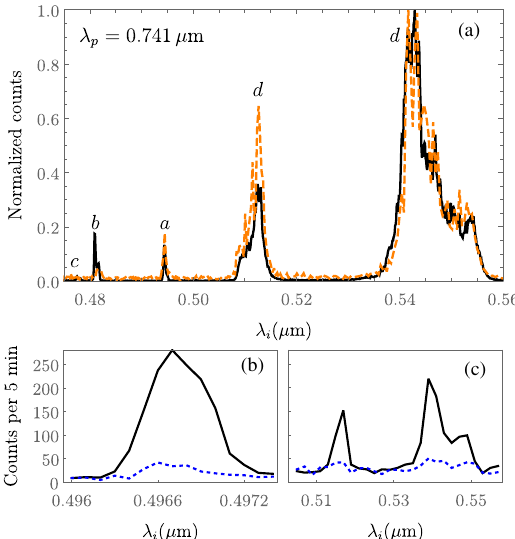
Figure 4. ( a ) Single-channel spectra for (cid:31) p = 0.741 µ m . The solid black line is the idler mode spectrum, while the dashed orange line represents the signal field, which we have mapped to the visible range through energy conservation. ( b , c ) Idler-channel spectrally-resolved coincidence photon counting for processes a and d ,